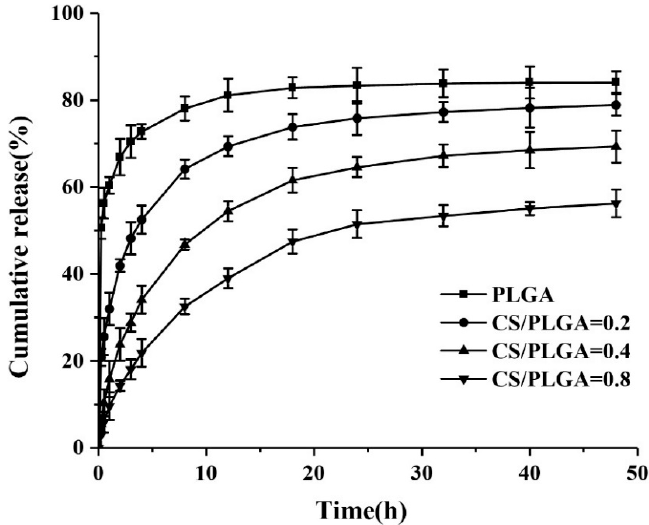
Figure 6. In vitro release of paclitaxel (PTX) from NPs at pH = 7.4.